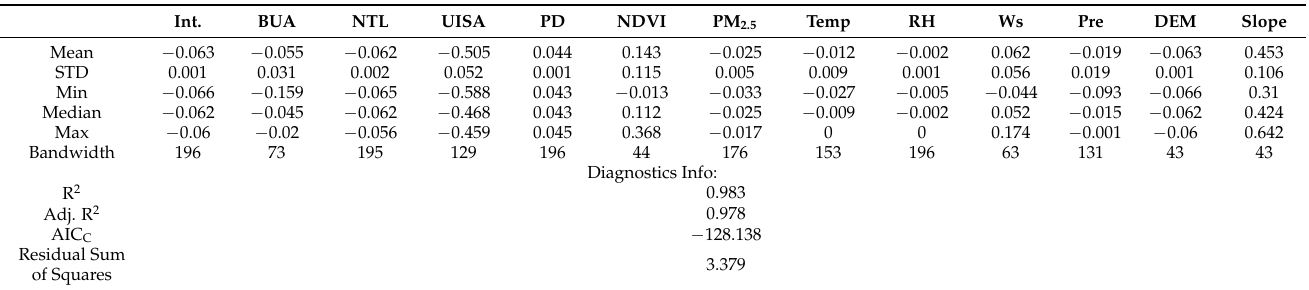
Table 4. Result of the MGWR model between carbon storage and drivers in 2010.